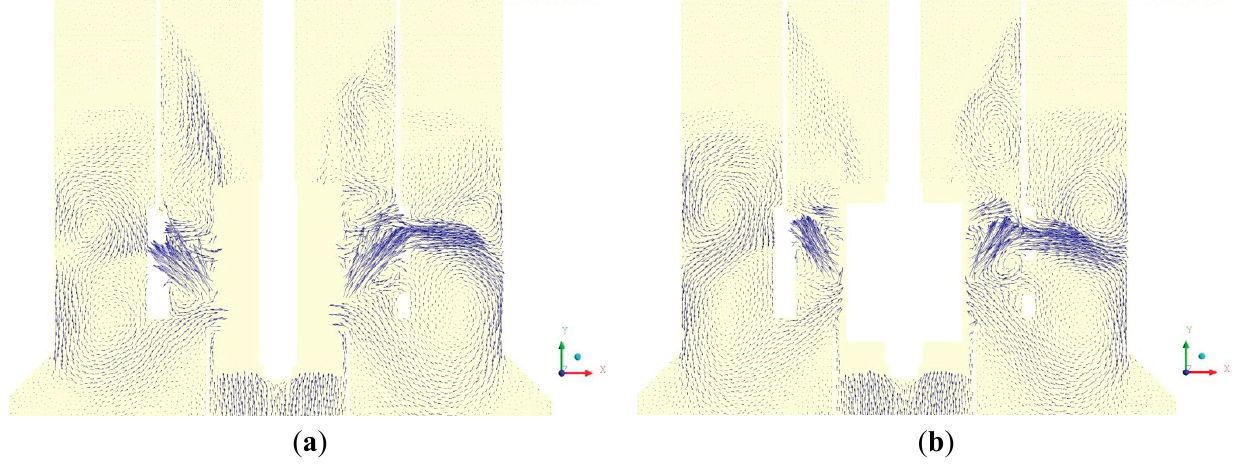
Figure 9. ( a ) Water superficial velocity vectors at maximum rate of air flow, d b = 0.7 mm; ( b ) water superficial velocity vectors at minimum rate of air flow, d b = 0.7